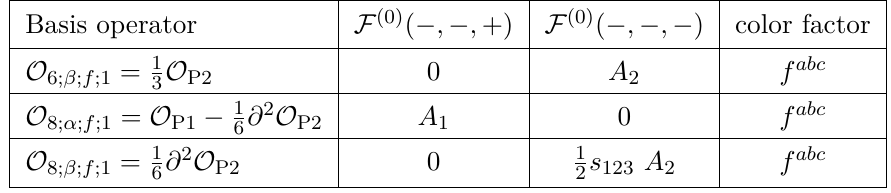
Table 6 . Final basis operators at dimension 6 and 8